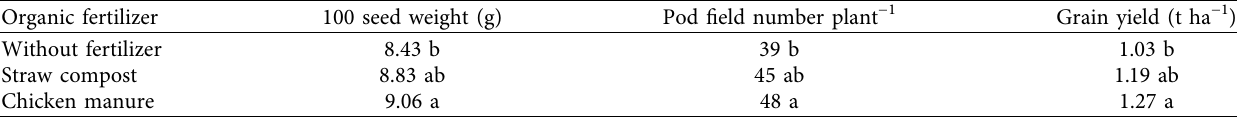
Table 2: Effect of organic fertilizer applied in the rainy season on 100 seed weight, pod field number, and grain yield of soybean in the first dry season.